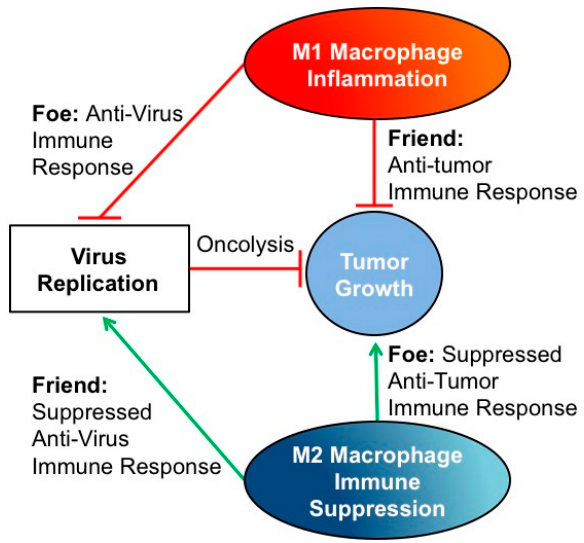
Figure 1. Influence of tumor-associated macrophages on oncolytic virotherapy. In general, although M1-like macrophages may lead to enhanced virus clearance, they appear to be a friend in terms of therapeutic effect as they enable anti-tumor immunity. In contrast, M2-like macrophages tend to be a foe as they enhance tumor growth and immunosuppression. There are exceptions to these generalizations, such as in glioblastoma, breast cancer, and pancreatic cancer where there is evidence of the opposite effects. There are thus likely as yet unknown factors unique to each tumor type or perhaps even to different individuals that influence the direction and impact of macrophages on virotherapy.